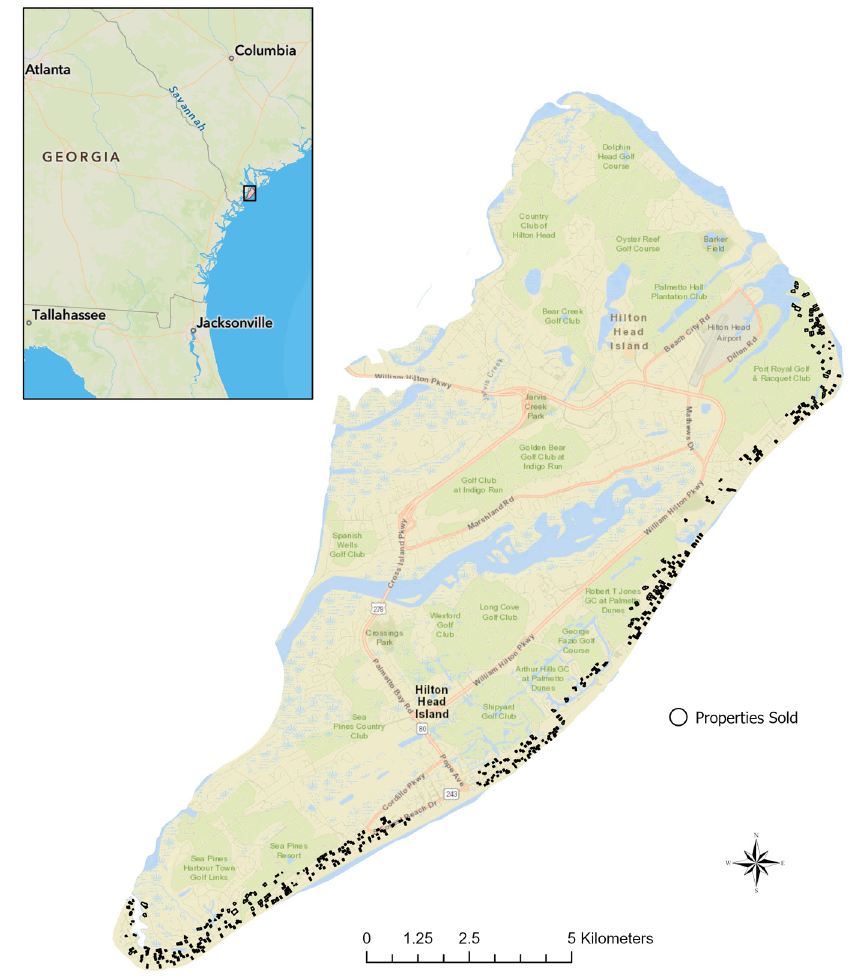
Figure 1. Location of the study area and the properties